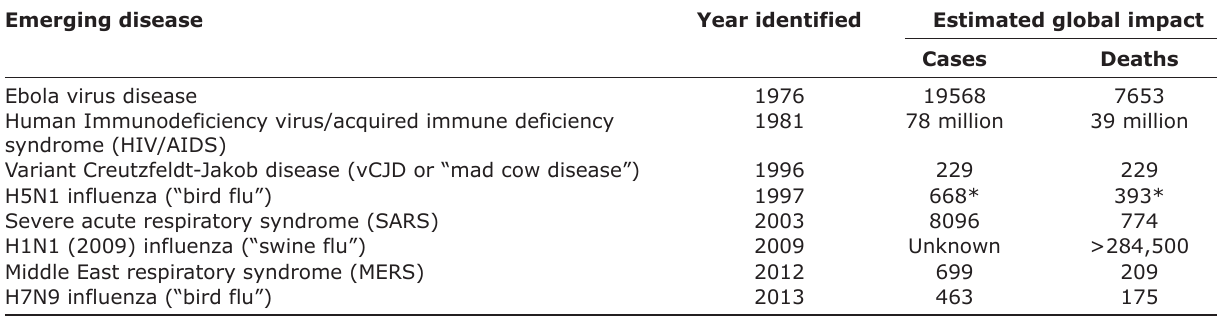
Table. 1: Selected viral zoonotic diseases since 1975 (Adapted from [24]). Emerging